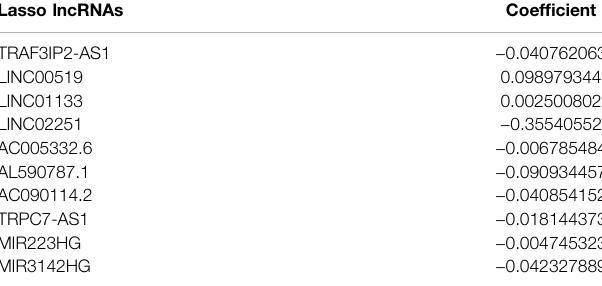
TABLE 2 | Ten PRlncRNAs extracted by lasso